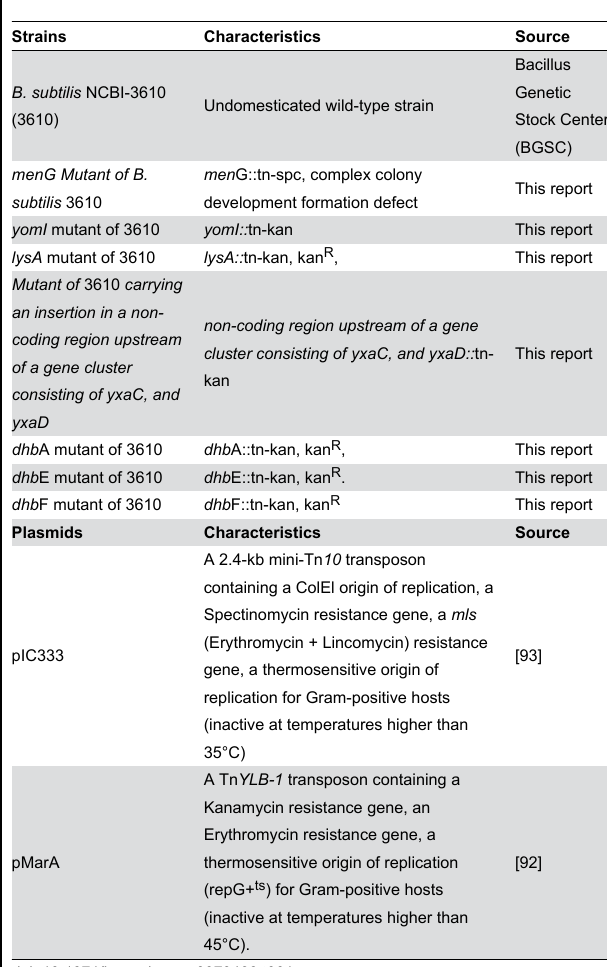
Table 1. Strains and plasmids used in this